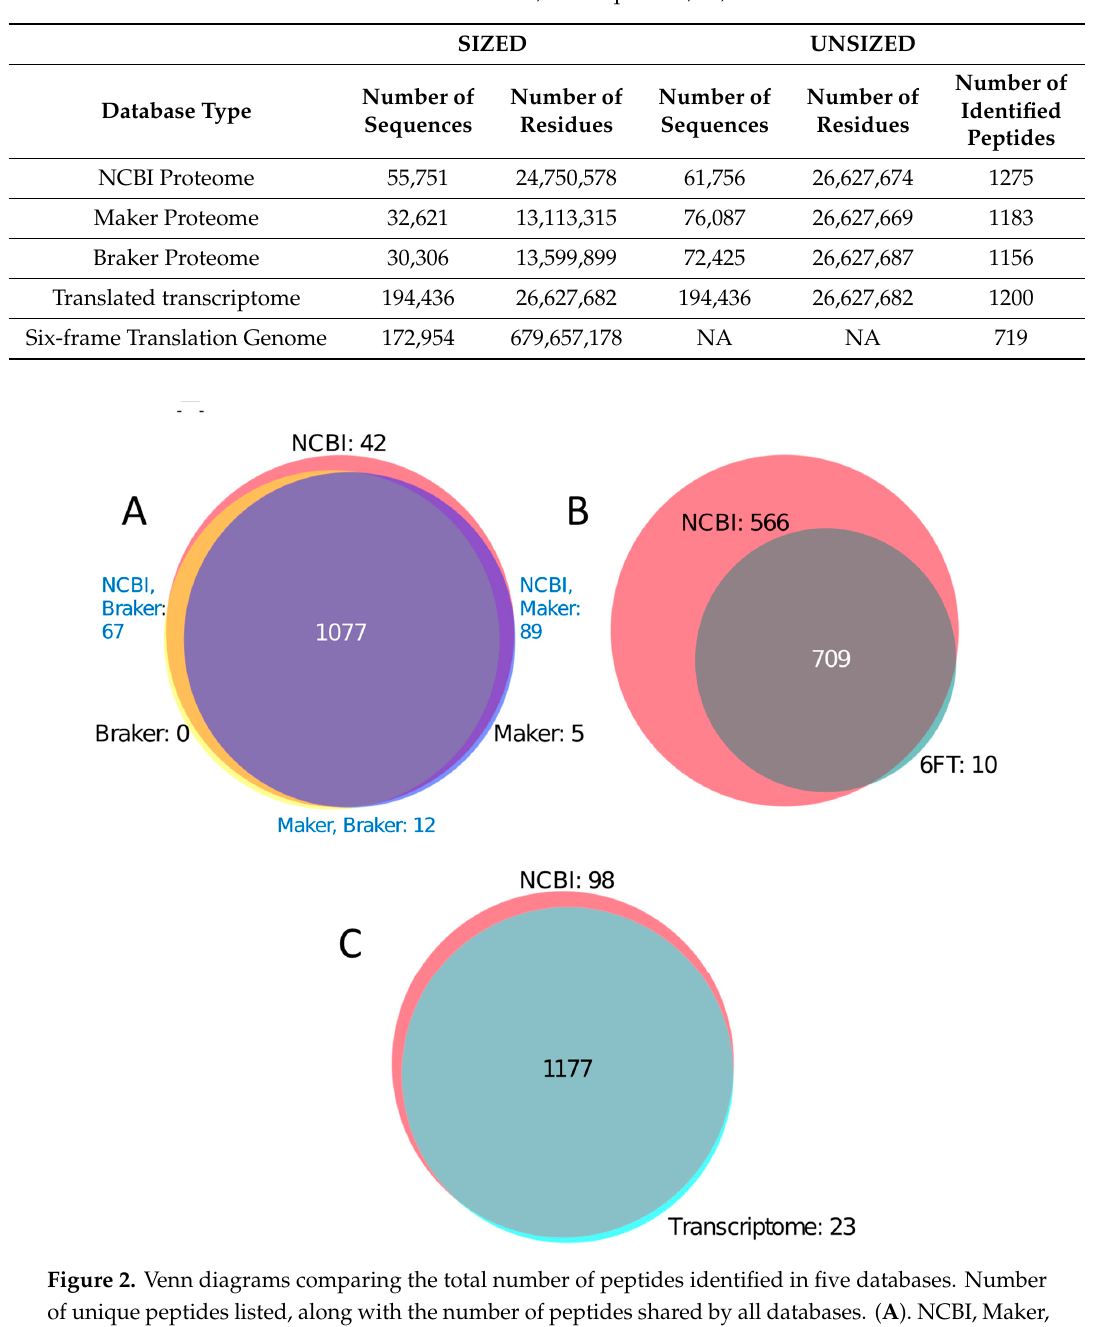
Table S5. Unique peptides across all databases aligned most frequently to heat shock proteins (HSPs), low ‐ temperature ‐ induced proteins, and seed storage proteins including vicilin ‐ like proteins and 11 s globulins. A list of all identified peptides as well as the most parsimonious set of proteins to which they align can be viewed in Supplementary Table 1. Seed storage proteins with high peptide coverage are critical for the MS/MS identification of tree nut species, as these are the most abundant proteins present in the nut and are targeted for marker development [8]. Thus, we were particularly interested in identifying which database(s) maximize the peptide coverage of these seed storage proteins. Two such peptides were uniquely identified in the NCBI database: TEAGEMR, which aligns to a vicilin ‐ like protein, and GLHGAAIPGCAETFQSESSSQFR, which is present in a legumin ‐ B like protein. Due to the superior performance of the NCBI database, we selected it as the basis for additional comparisons throughout this paper. To determine whether a database constructed from a 6FT of the genome contributes novel information for the MS/MS analyses of nuts, we next compared results from searches against a 6FT